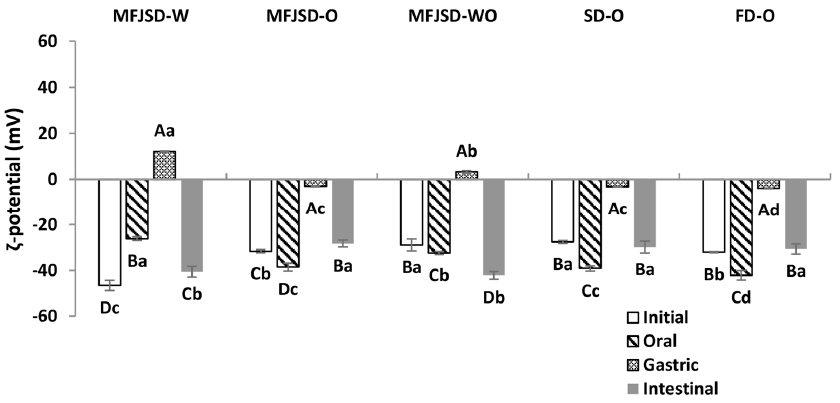
Figure 6. Zeta potential of microcapsules after in vitro digestion. MFJSD-W, MFJSD-O, and MFJSD-WO: microcapsules produced by microfluidic-jet spray drying, using WPI only, OSA only, and a combination of WPI/OSA (50/50 w / w ) as wall materials, respectively; SD-O: microcapsules produced by two-fluid nozzle spray drying, using OSA only as wall material; FD-O: microcapsules produced by freeze-drying, using OSA only as wall material; WPI: whey protein isolate; OSA: octenylsuccinic anhydride modified starch. The lowercase letters indicate significant difference in different samples with the same digestion phase ( p < 0.05); the uppercase letters indicate significant difference in same sample ( p < 0.05).